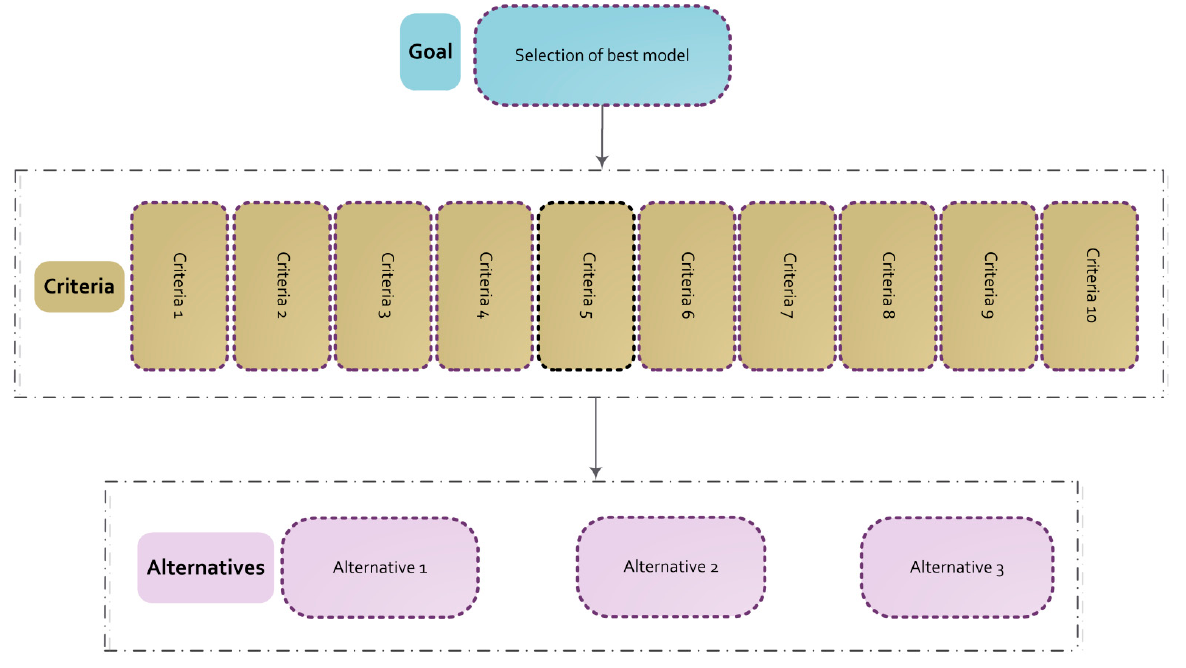
Figure 4. Hierarchical model to choose the appropriate alternative.